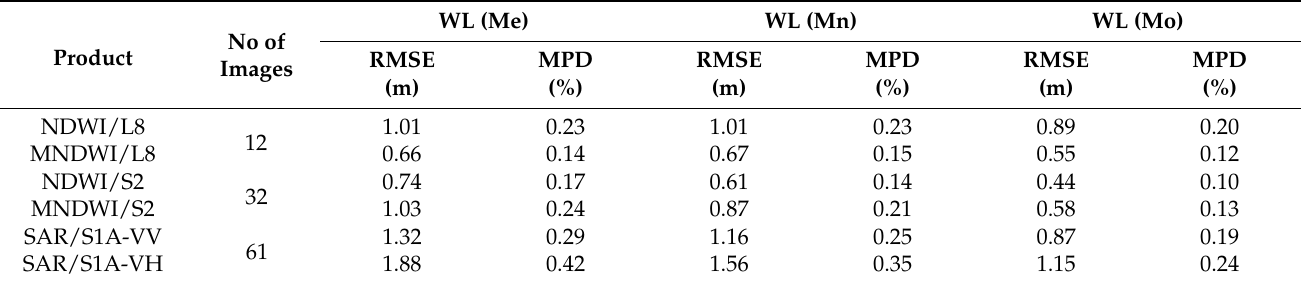
Table 7. RMSE and MPD results in the assessment of hydrological monitoring.